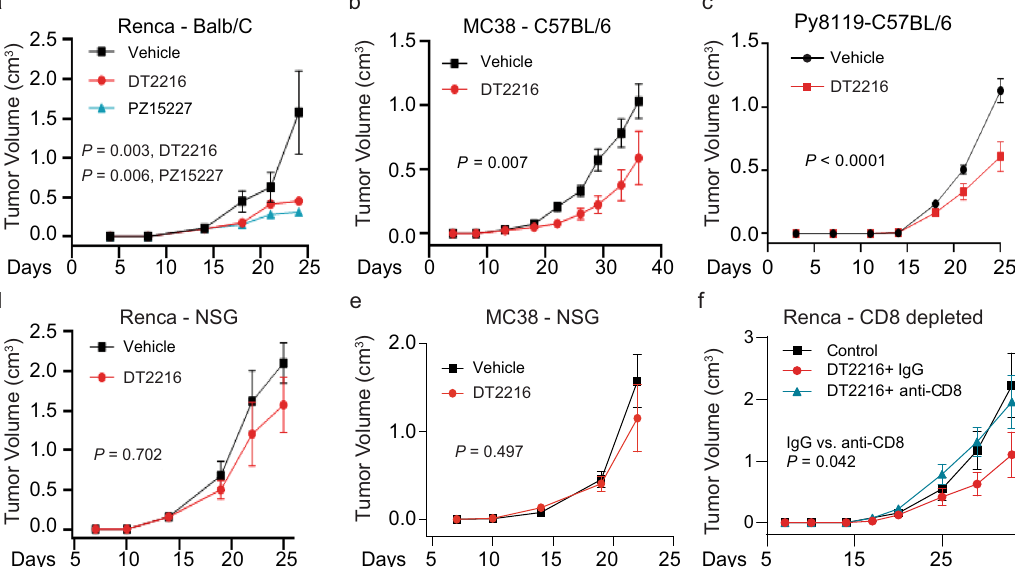
ANOVA was performed for all tumor growth curves with P values for the interaction between the curves